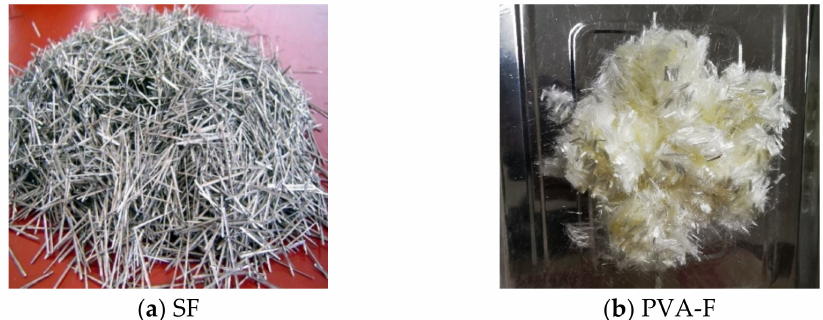
Figure 2. Types of fibre.